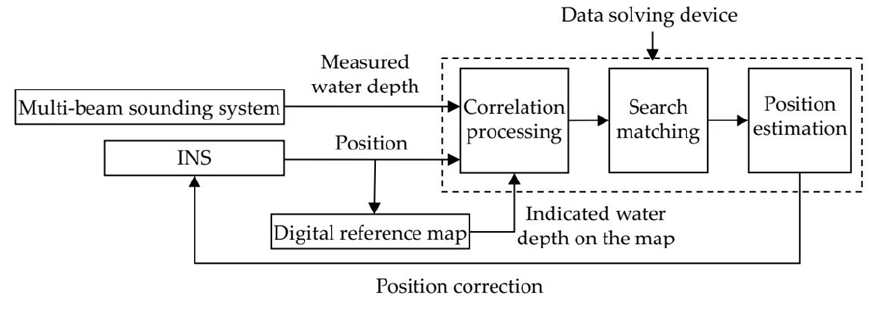
Figure 1. The principle of TAN.